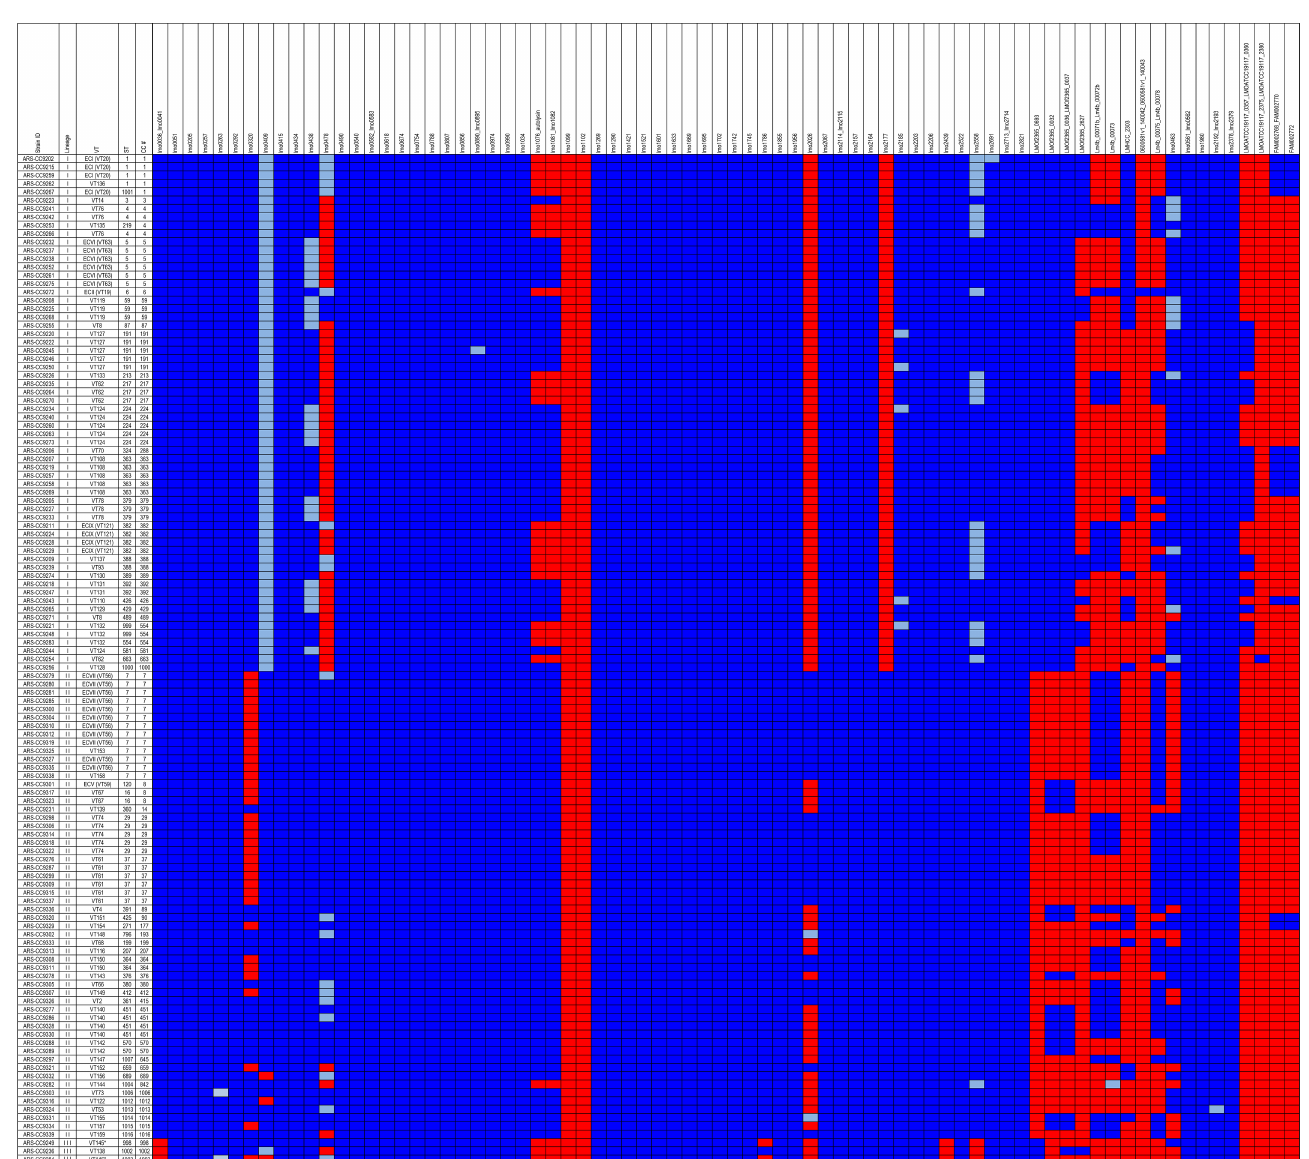
Fig 5. Presence/absence of genes associated with virulence among the study isolates. Blue = detected. Light blue = shorter than the reference gene used in the analysis. Red = not detected. Columns 1 to 62 (at the bottom of the figure) were based on the analysis described by Kuenne et al. [47] and columns 63 to 76 were based on the analysis described by Maury et al.